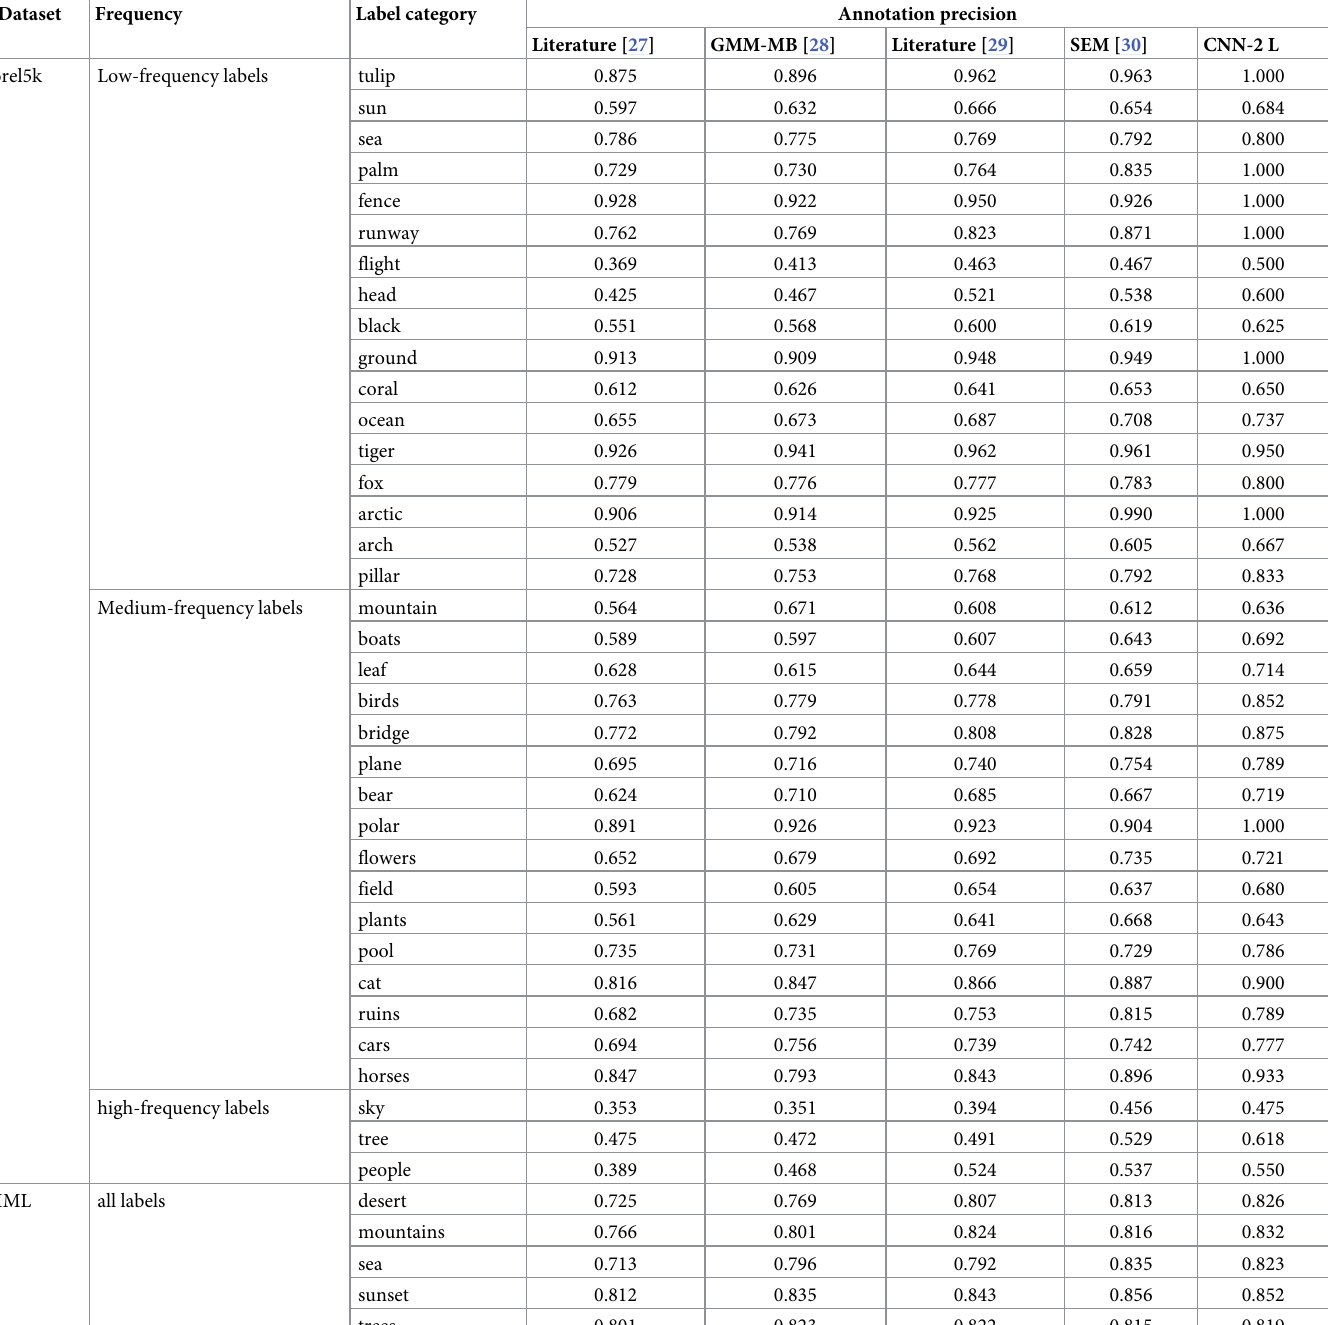
Table 2. Comparison of annotation precision for single category labels using different